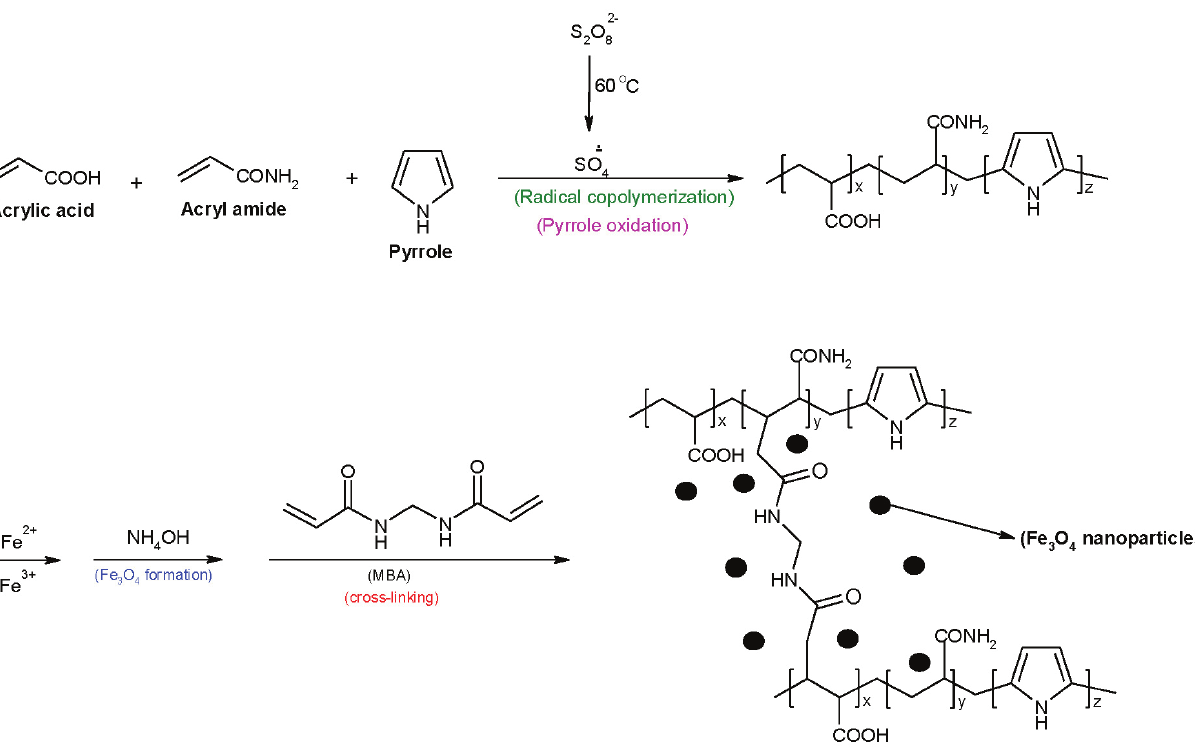
Fig. 1 – Proposed mechanistic pathway for the synthesis of MHN adsorbent